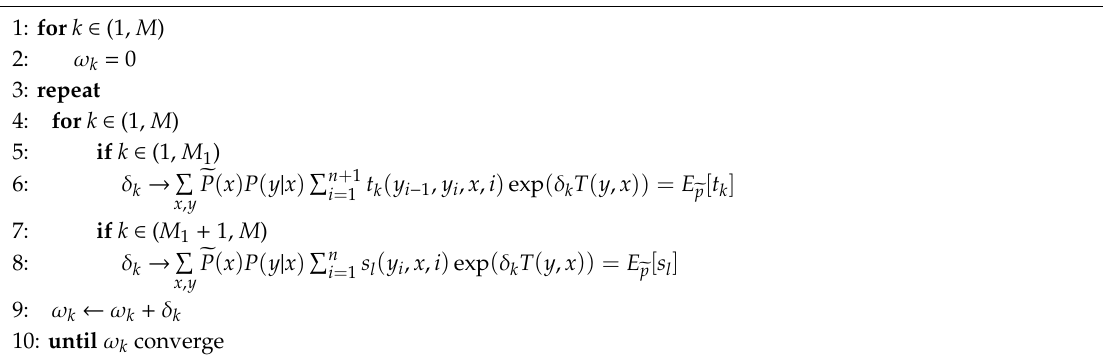
Algorithm 1. Improved iterative scaling algorithm.